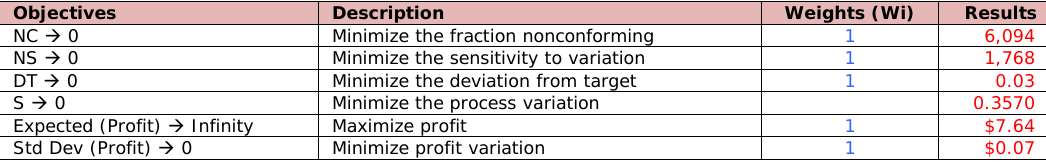
Table 3. “Expected performance of the process with a 10% reduction in